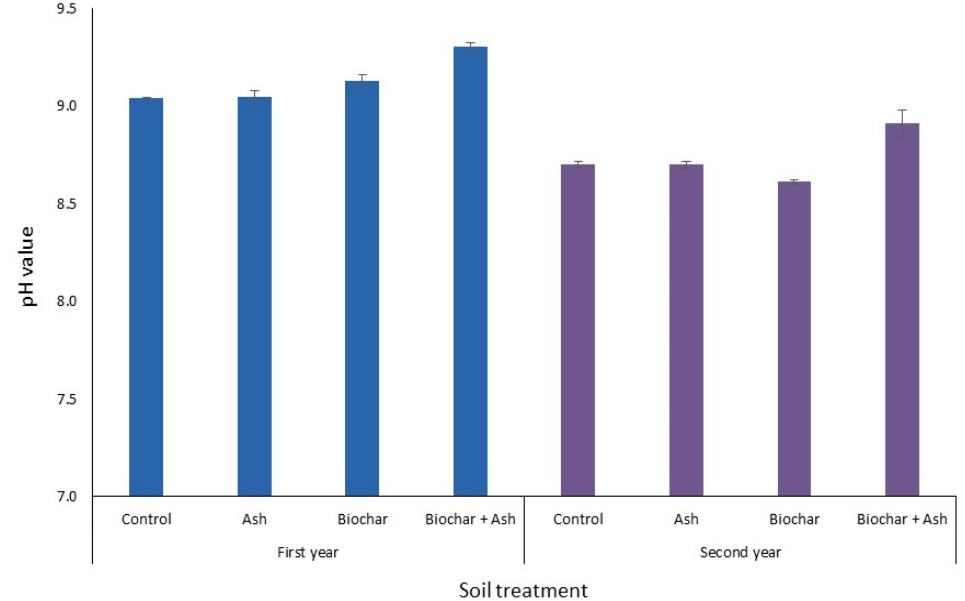
Figure 2. Pyrolysates’ pH, produced from giant miscanthus biomass collected from the control, ash, biochar, and biochar + ash soil treatment plots, one and two years after planting ( n = 12). In accordance with the result of the Bonferroni test, the pH values were not significantly (α ≤ 0.05) different among treatments (separate comparison for each year).